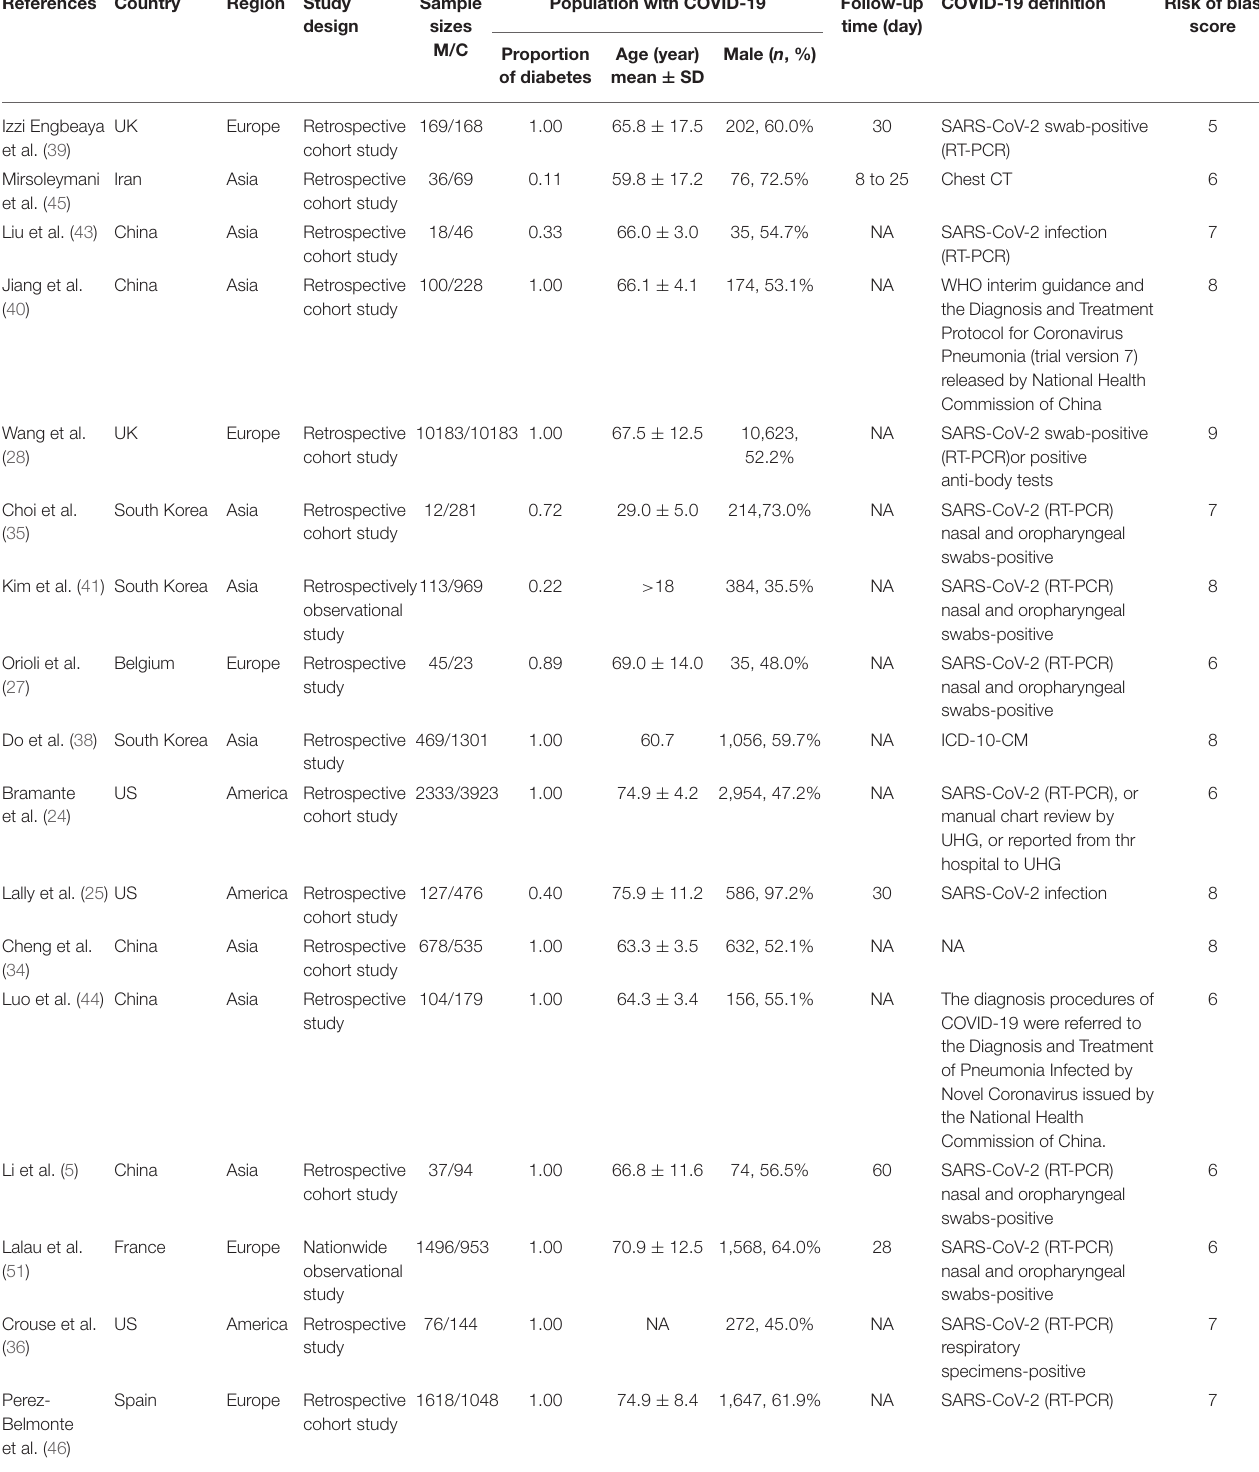
TABLE 1 | Characteristics of included